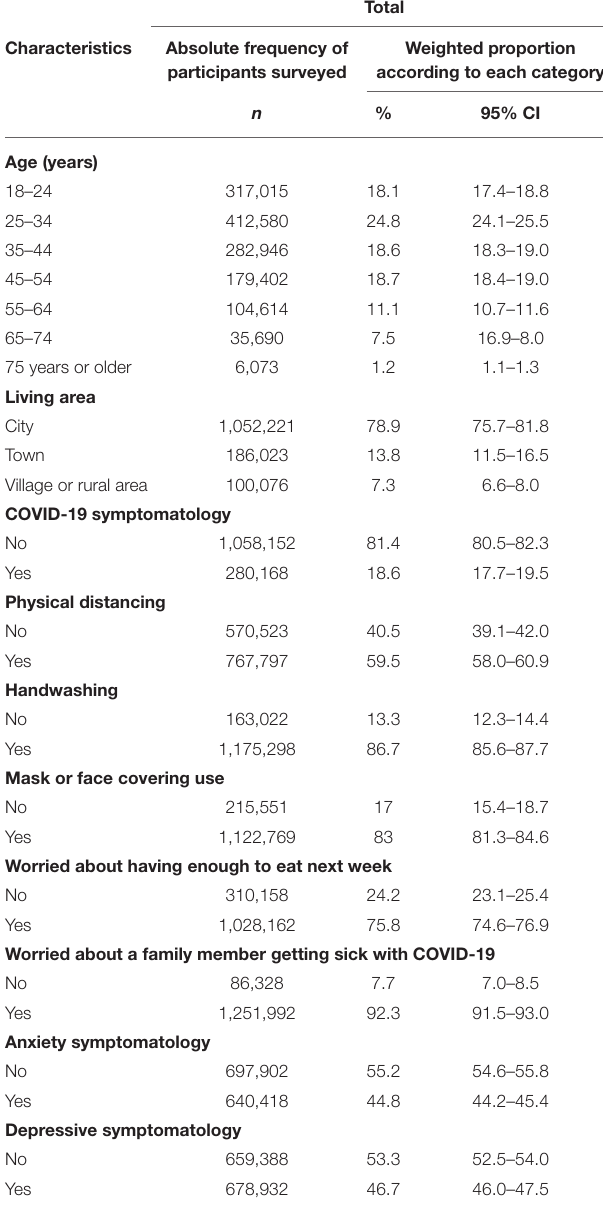
TABLE 1 | Descriptive and bivariate analysis of the study sample characteristics ( n = 1,338,320; N = 11,524,713).